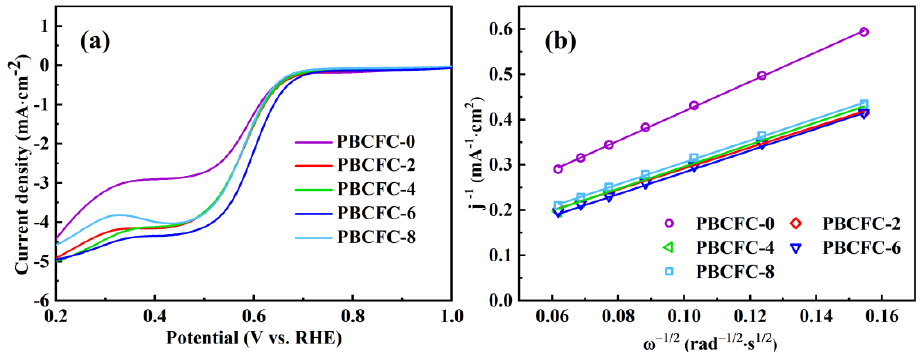
Figure 2. SEM images of PBCFC-0 ( a ), PBCFC-2 ( b ), PBCFC-4 ( c ), PBCFC-6 ( d ), and PBCFC-8 ( e ) samples.